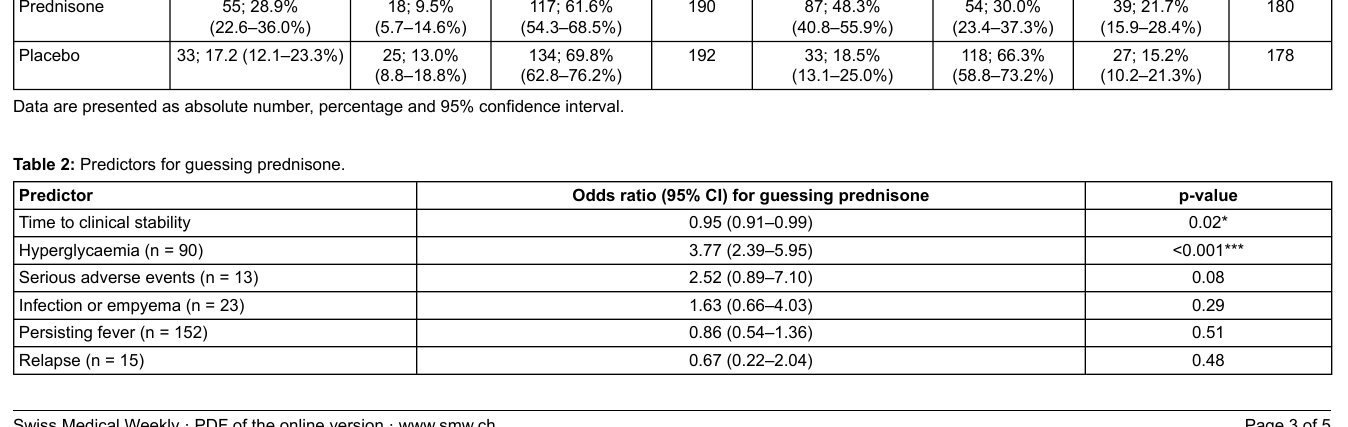
Table 1: Patients’ and physicians’ guesses according to treatment group. Treatment alloca- tion